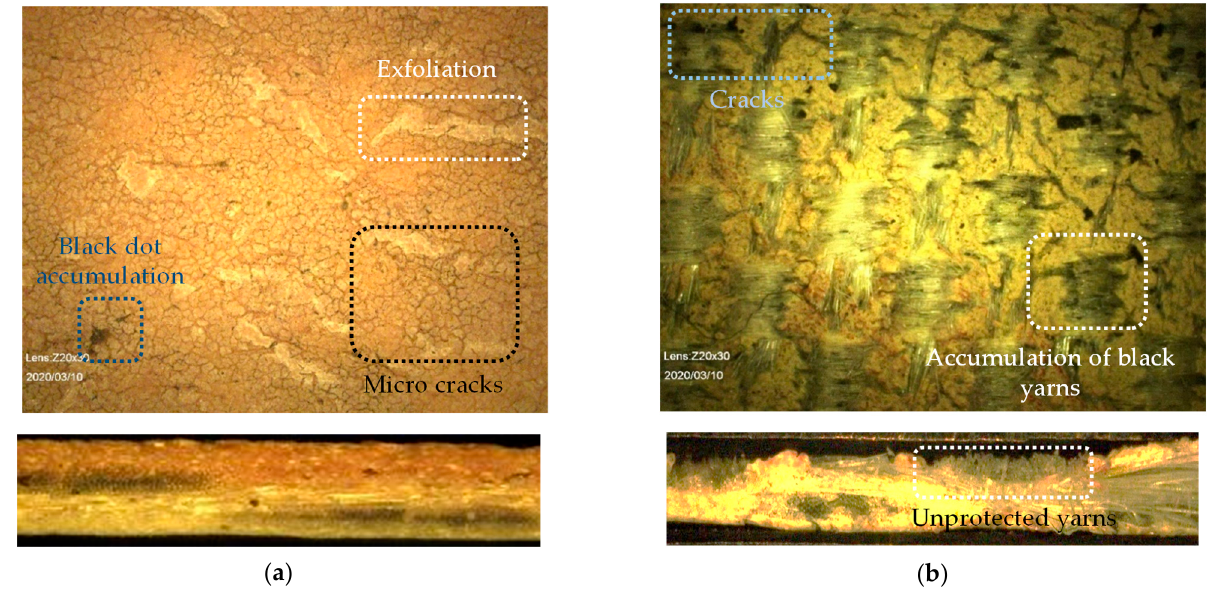
Figure 2. Dismantled fabric taken from realized projects: ( a ) 23-year-old PET-PVC Type III; and ( b ) 38-year-old PET-PVC Type II with PVDF top coating, taken by digital microscope (see Section 3.3.5).